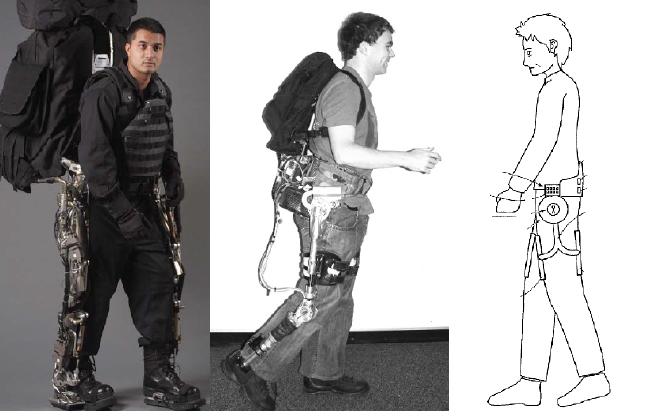
Figure 2. BLEEX Exoskeleton ( left ) [20], the quasi-passive exoskeleton ( center ) [21], and the “Mo- tion Assisting Device”